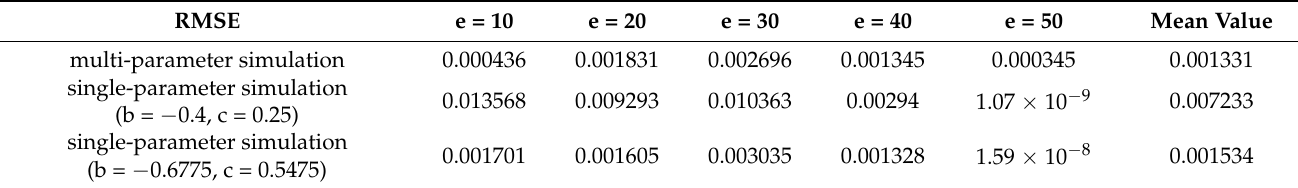
Table 2. RMSE comparison of the multi-parameter simulation, single-parameter simulation with the empirical parameters given by Lucey and single-parameter simulation with the improved empirical parameters. RMSE e = 10 e = 20 e = 30 e = 40 e = 50 Mean Value multi-parameter simulation 0.000436 0.001831 0.002696 0.001345 0.000345 0.001331 single-parameter